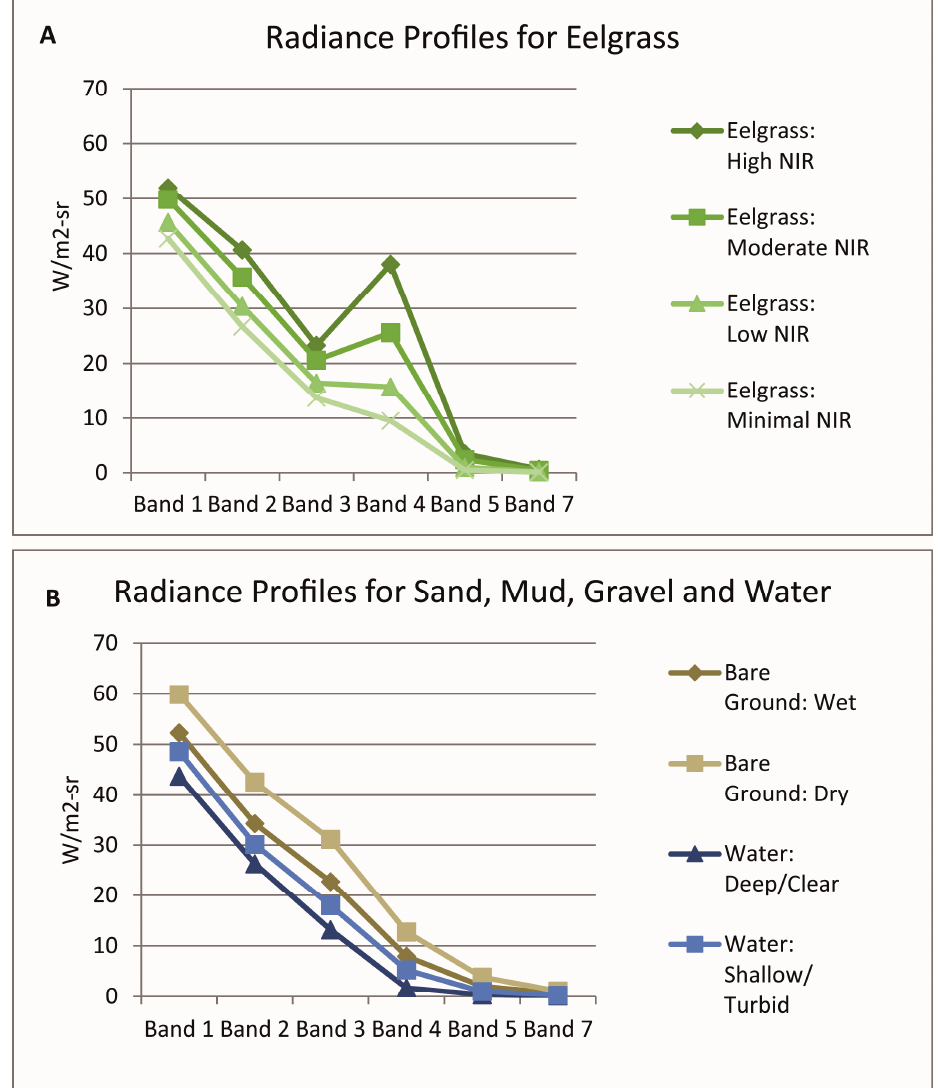
Figure 3. Radiance profiles plotting mean band values for each training class ( a ) differentiating four classes of eelgrass based primarily on strength of the near infrared (NIR) signal (band 4) and ( b ) indicating two classes of bare ground and two classes of